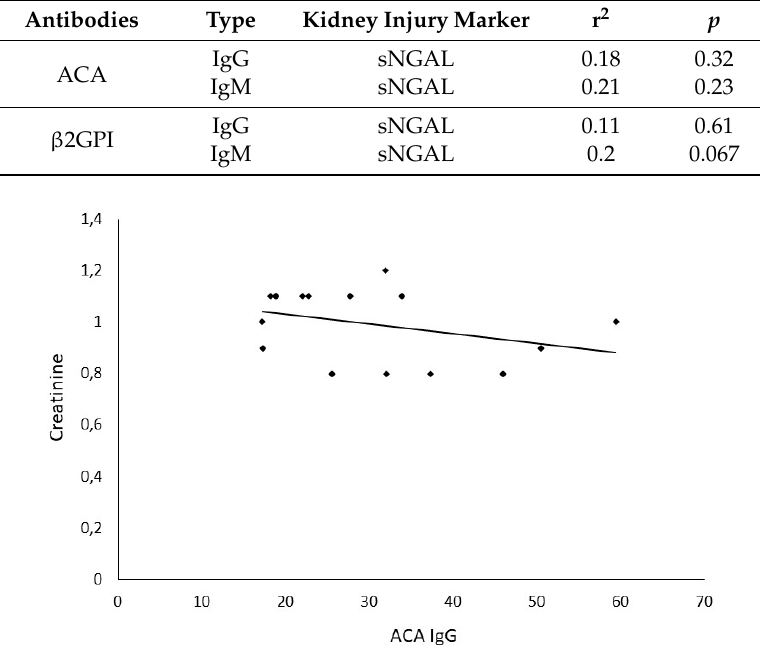
Table 4. Correlation between aPL of the IgG and IgM Isotypes and sNGAL in control subjects.